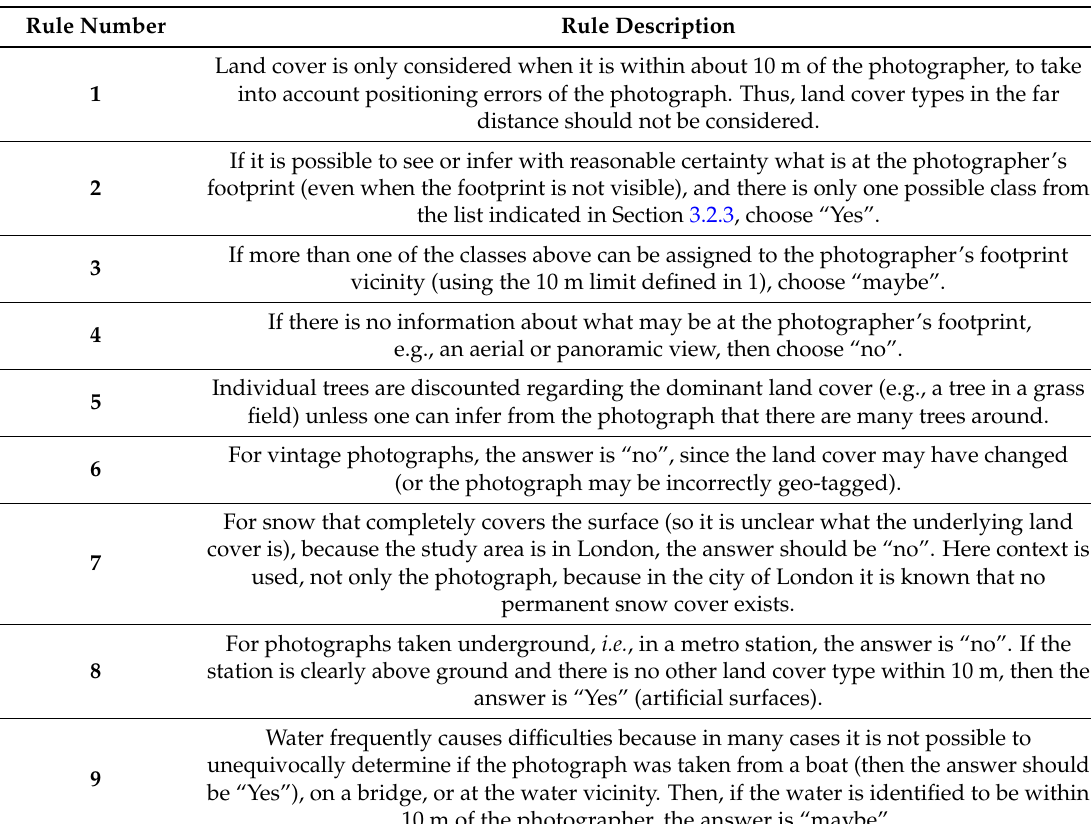
Table 3. Rules used to assist in the classification of the photographs as useful for land cover applications. Rule Number